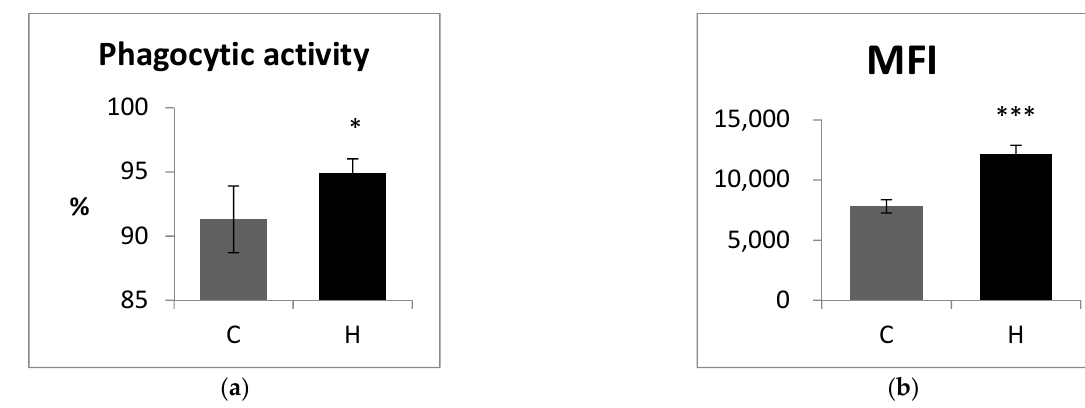
Figure 2. Influence of 0.5% HS on phagocyte activity in layer blood evaluated as ( a ) percentage of active phagocytes (phagocytic activity) and ( b ) engulfing capacity of the phagocytes (expressed as mean fluorescence intensity—MFI). C: control group; H: layers fed a diet enriched with supplementation of 0.5% HS. Columns marked with stars are significantly different from control: * p < 0.05; *** p < 0.001.